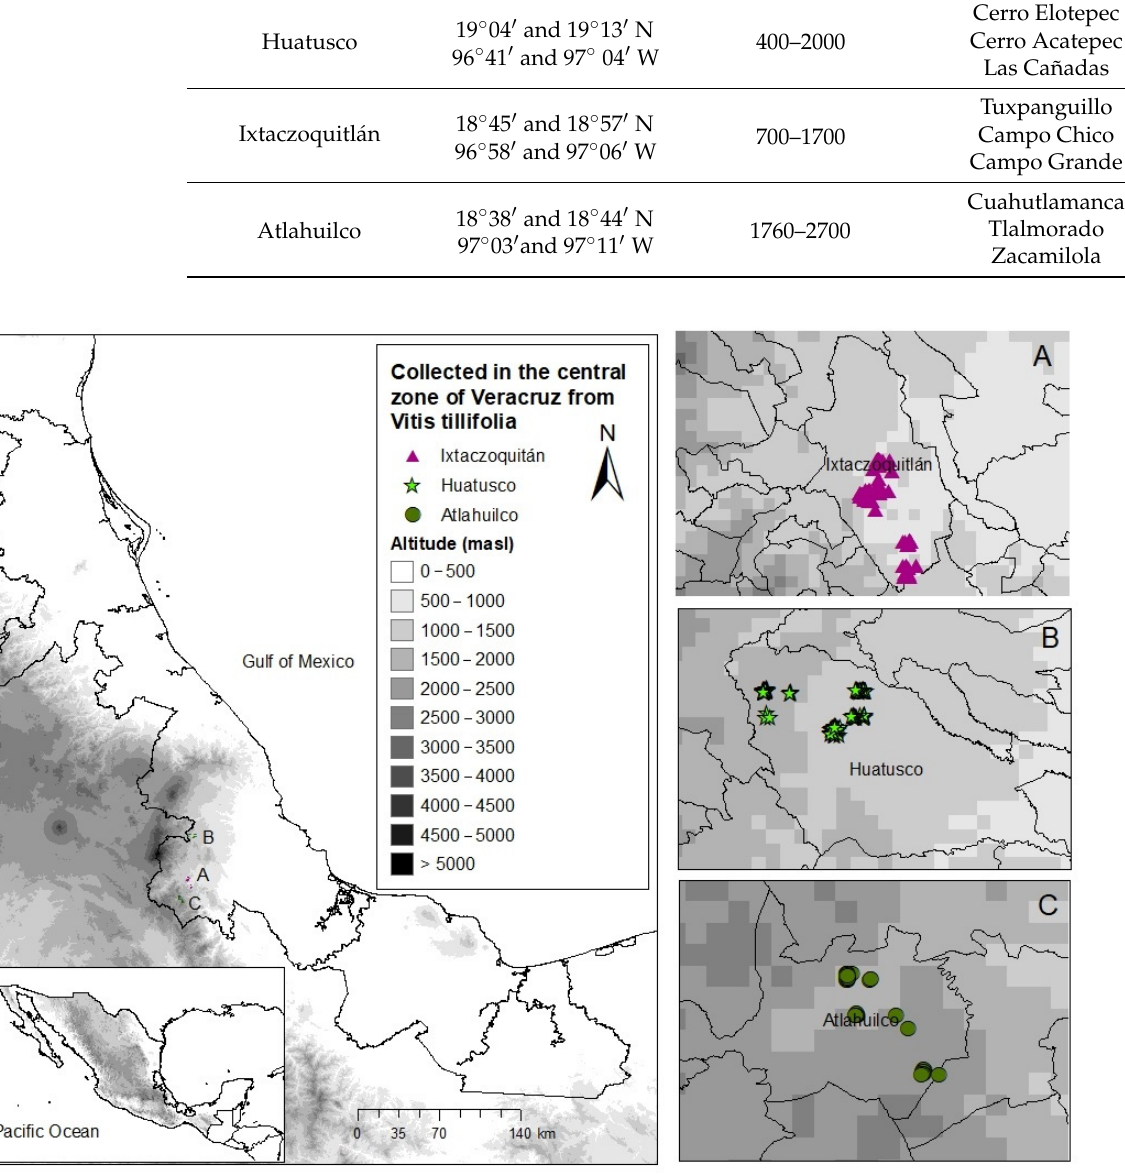
Figure 2. Location of the three study municipalities in the central zone of the state of Veracruz, México. Sampling sites: ( A ) Ixtaczoquitlan; ( B ) Huatusco y; ( C ) Atlahuilco.